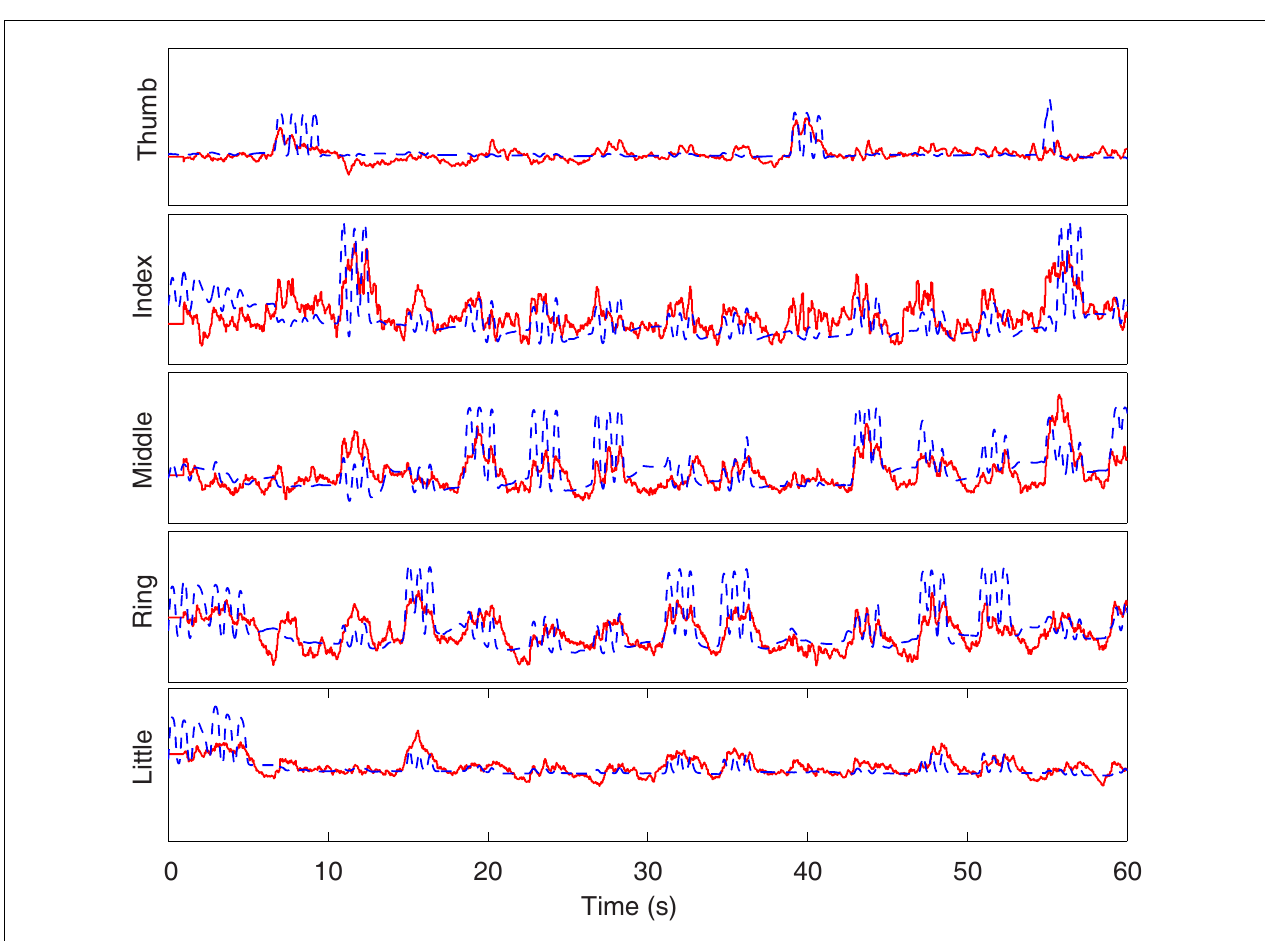
FIGURE 4 |Time course of the predicted (solid red) and actual (dash blue) finger flexion for the first 60s of the testing data set from subject 3.